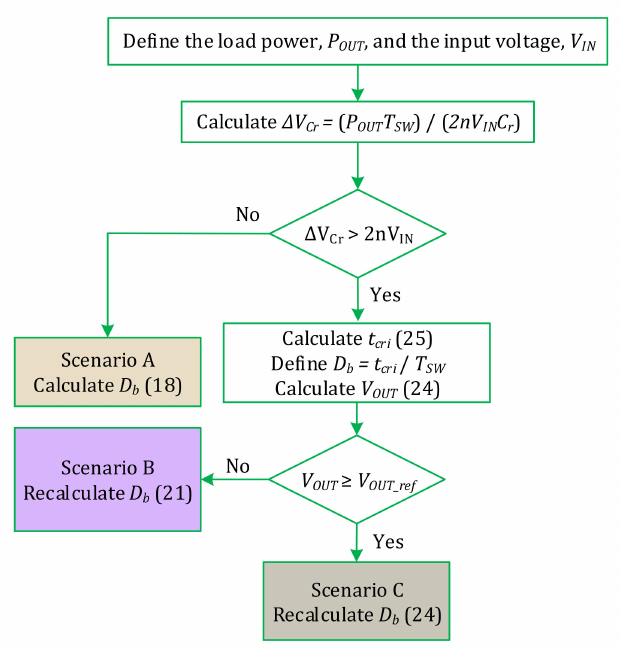
Figure 9. Flowchart of the operation scenario selection for the converter in the boost - SRC